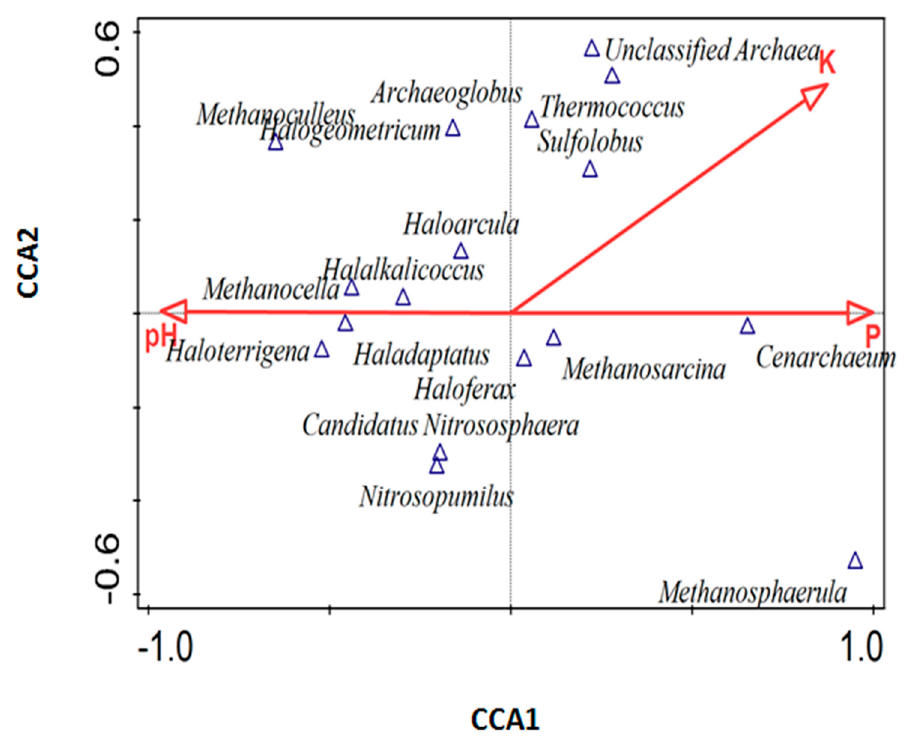
Figure 5. Canonical correspondence analysis (CCA) of the archaeal community distribution and soil physicochemical properties of both termite mound soils and the surrounding soil samples.